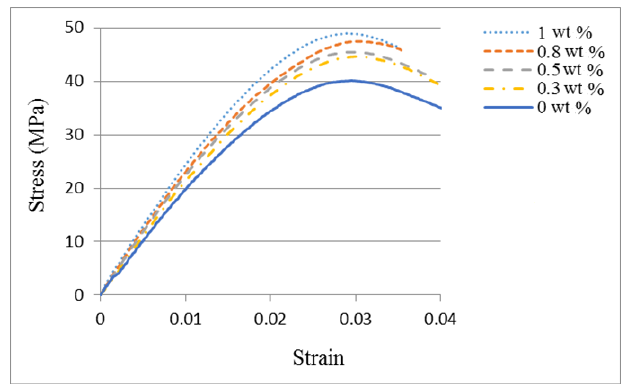
Figure 5. Stress and strain relation for the nanocomposite with di ff erent MWCNT loadings.